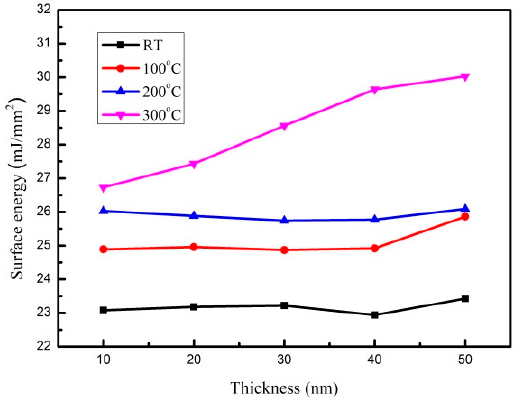
Figure 6. Surface energy of CoFeY films.